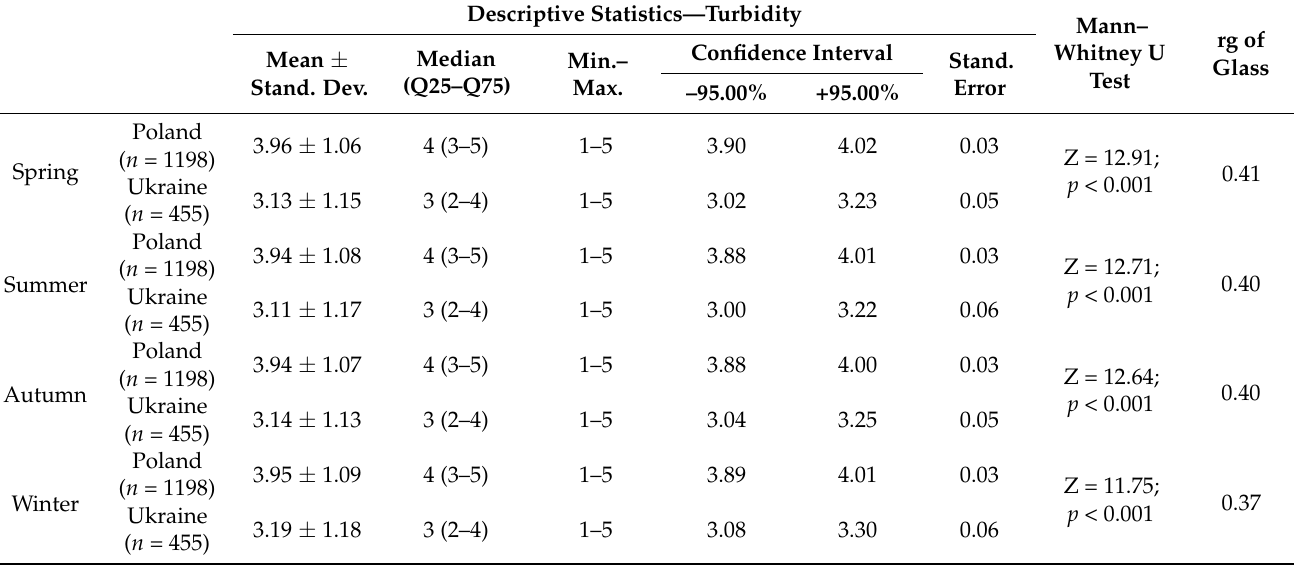
Mann– rg of Whitney U Test